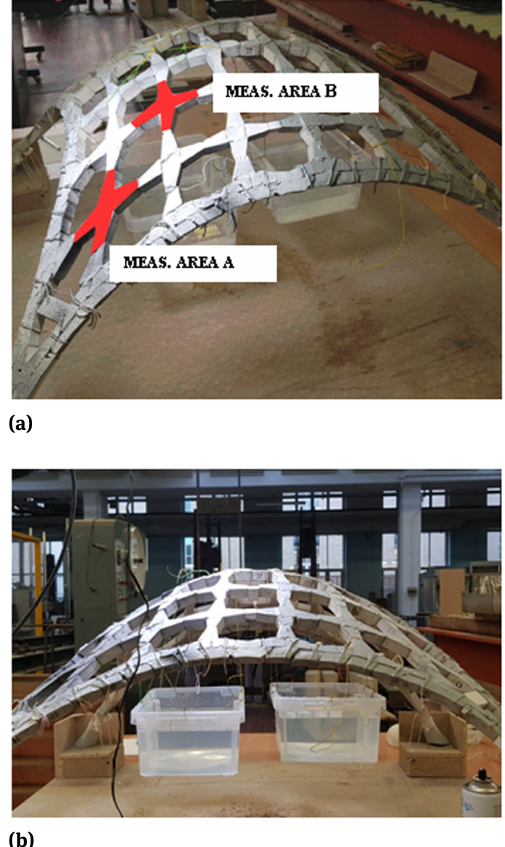
Figure 13: Physical model of the vault. In red the portion of the structure monitored by DIC (a). The loading procedure is obtained by different loads applied on the lower part of the structure during different loading steps realized by different water containers